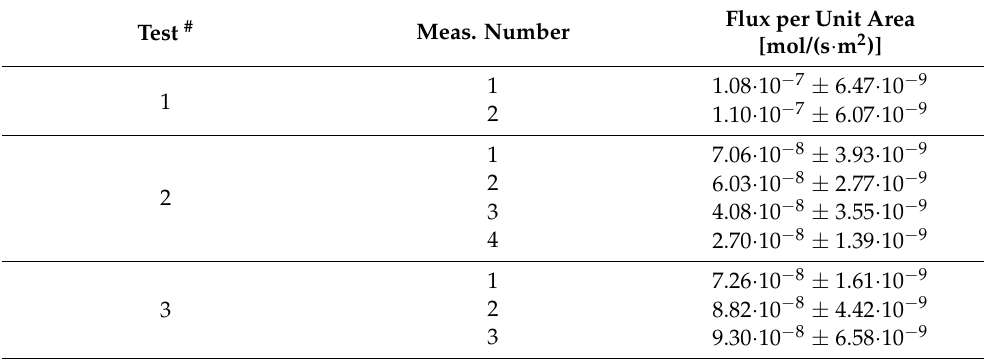
Table 4. Hydrogen permeated flux per unit area (with experimental